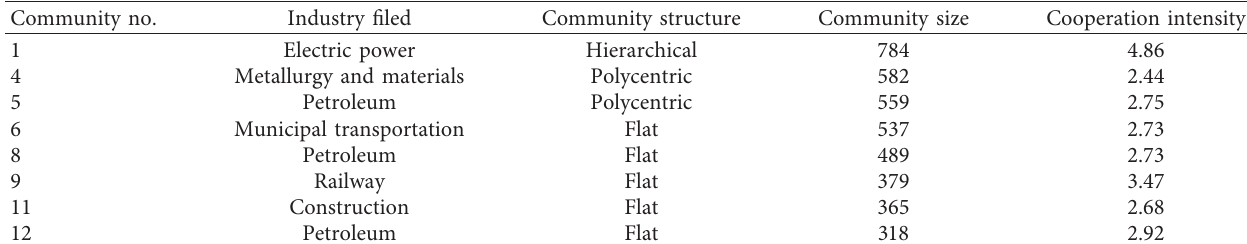
Table 6: Detailed information on the communities of innovation with industrial characteristics. Community